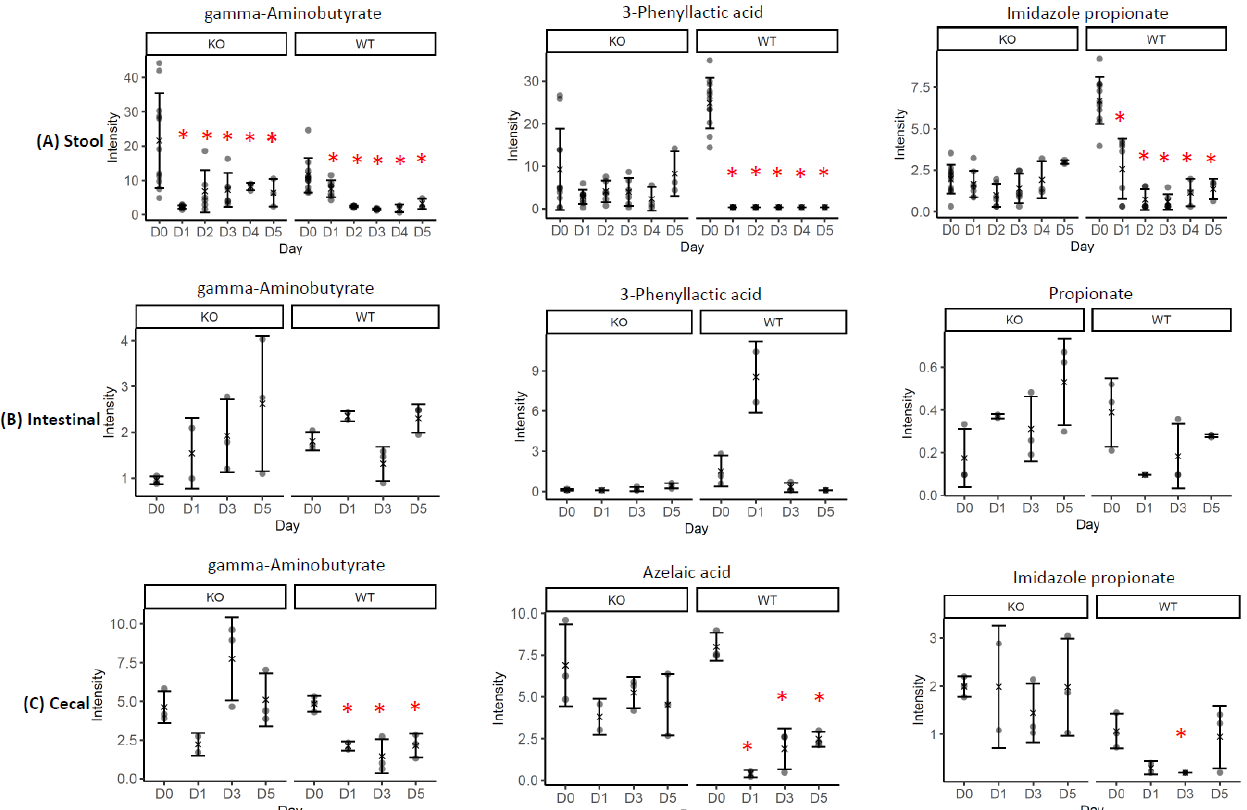
Figure 3. Box plots of the intensity of the selected bacteria-associated metabolites in the stool ( A ), small intestinal ( B ), and cecal contents ( C ) from both the KO and WT mice. Whereas D0 = prior to the Cef treatment, D1, 2, 3, 4, and 5 means 1, 2, 3, 4, or 5 days after the Cef treatments. *: significant changes at p < 0.05. Error bars denote the standard deviations (SDs).